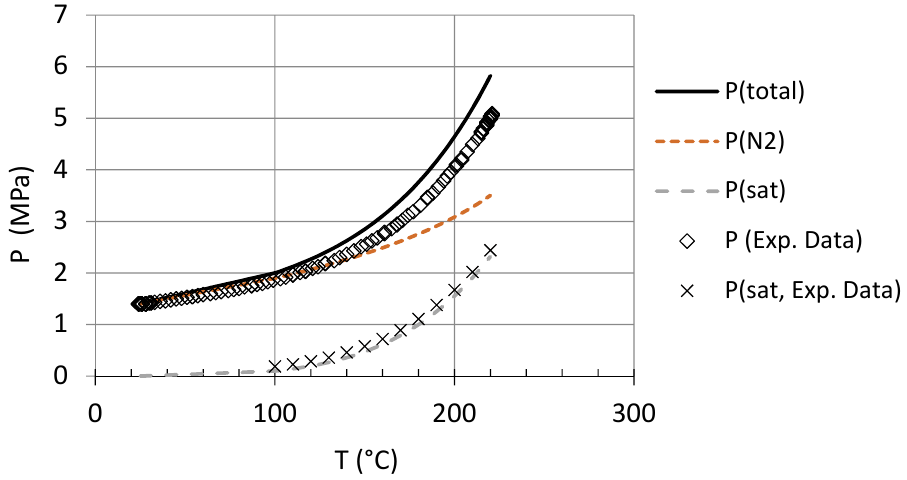
Figure 4. Comparison of the theoretical total pressure P(total) calculated from the partial pressures for N 2 P(N 2 ) and saturated water vapor P(sat) to the measured values for pressure P and P(sat) in the reactor for VF o = 0.63. Comparison of the measured and theoretical values shows clearly that the contribution of the saturated water vapor to the total pressure is not affected by the initial addition of N 2 gas. The small deviation between the calculated pressure and the measured can be due to inaccuracies in the pressure measurement or in estimating the reactor volume, and the assumption that N 2 behaves as an ideal gas with no solubility in the liquid. Nevertheless, the difference does not mask that the fact that the addition of pressure to the reactor headspace does not change the behavior of water.